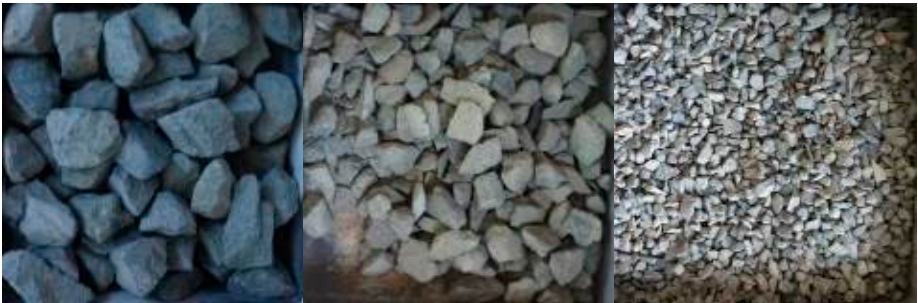
Figure 3. Processed basalt aggregate. Table 4. Test results of various indicators of basalt coarse aggregate.